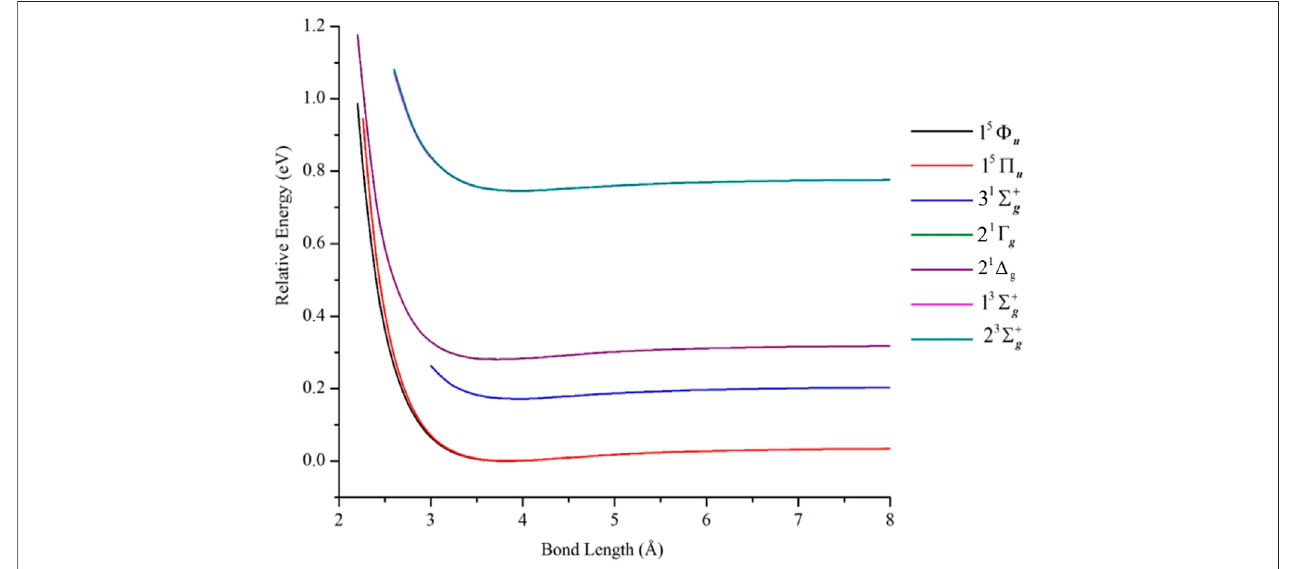
FIGURE6| PECsofelectronicstatesofNi 2 fromthe 3 F 4 (3d 8 4s 2 )+ 3 F 4 (3d 8 4s 2 )manifold,computedattheGVVPT2leveloftheoryusingthecc-pVTZbasissetand reference macrocon fi gurations κ 5 ( n ) to κ 7 ( n ). All energies are plotted relative to the lowest energy value of the 1 5 Φ u term.